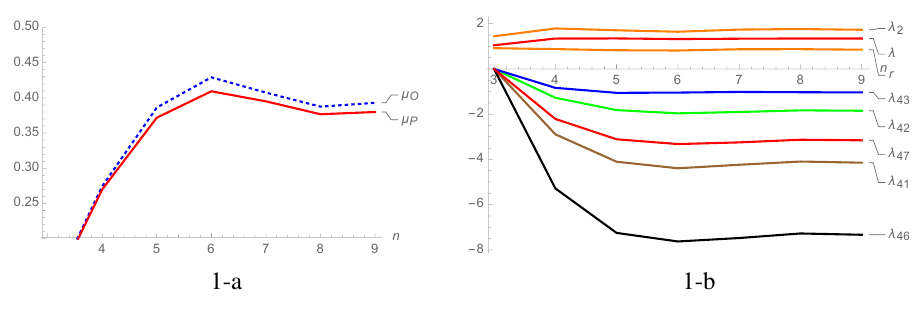
Figure 1. 1-a:Values of the parameters of the fixed point solution of the LPA truncations for di ff erent orders n of the polynomial (3 ≤ n ≤ 9). The masses (which equal intercept minus one) µ P (red curve) and µ O (blue dotted curve) for the Pomeron and Odderon fields are in the left panel. 1-b The first non zero couplings λ,λ 2 ,λ 41 ,λ 42 ,λ 43 ,λ 46 ,λ 47 , r are reported on the right